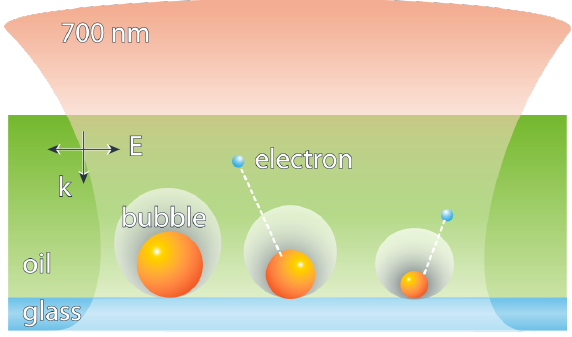
Figure 1: Schematic depiction of gold particles on glass substrate covered with immersion oil. The incident focused fs laser beam creates a nanobubble around the particle and then stimulates the photoemission of an electron, which leaves luminescent defect traces in the